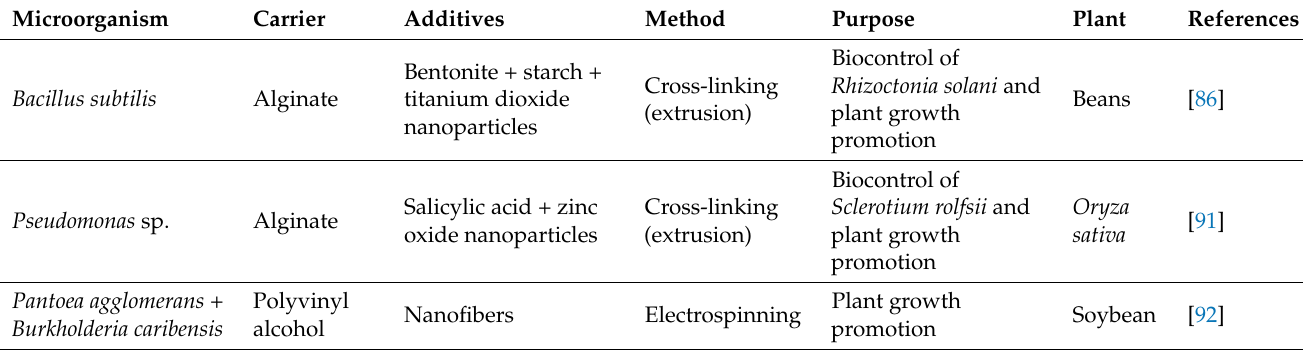
Table 2. Examples of characteristics of nanoencapsulations of PGPMs and their application purposes.